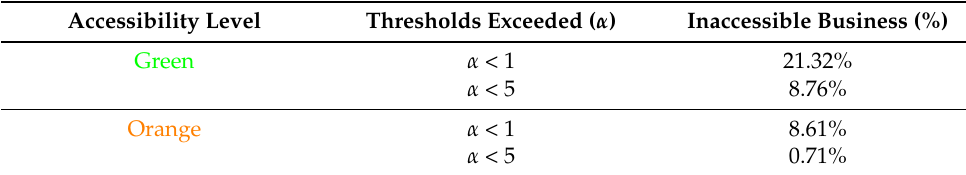
Table 9. Commercial accessibility after restoration.